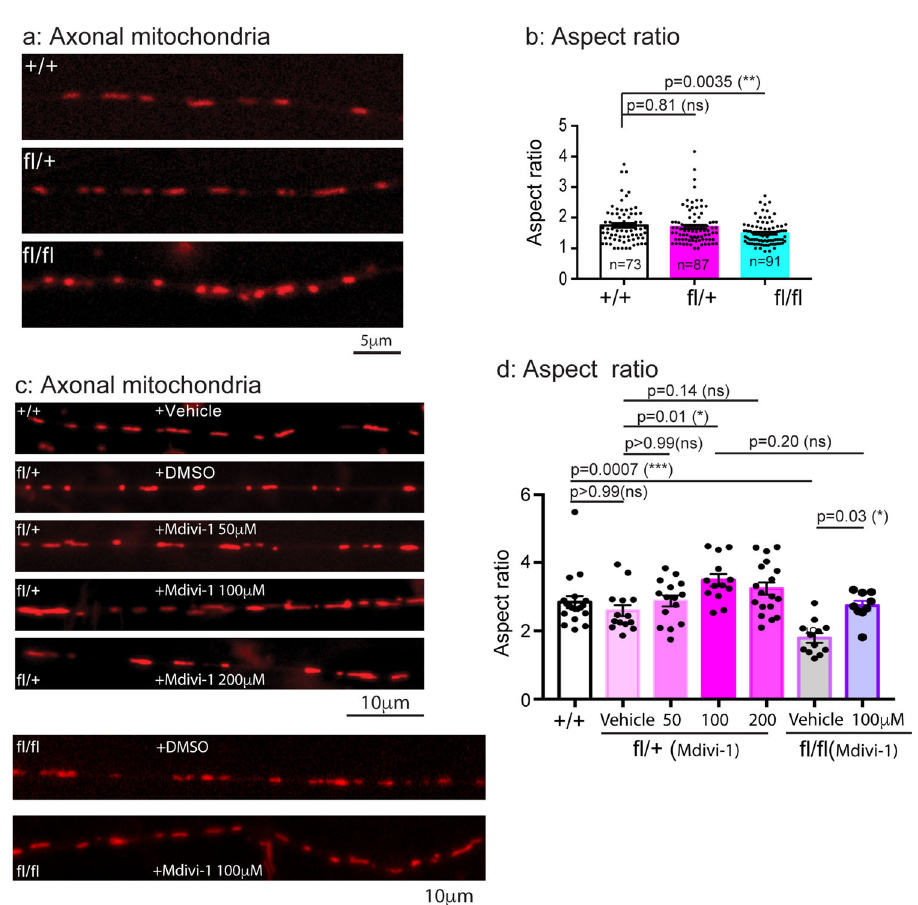
Fig. 4 Mitochondria are signi fi cantly fragmented in axons of fl / fl E18 DRG sensory neurons of the CMT2B mutant mice. E18 DRG sensory neurons from + / + , fl / + , fl / fl embryos were dissected, cultured on PLL-coated cover-glasses and maintained as described in Materials and Methods. At DIV4-7, neurons were treated with Mito Tracker and time-lapsed images were captured with live imaging microscope. a : representative images of axonal mitochondria from + / + , fl / + , fl / fl ; b : Aspect ratio for each group was measured as in Figs. 1 – 3. The numbers of mitochondria in b were analyzed are: n = 73 for + / + , n = 87 for fl / + , n = 91 for fl / fl . In c , representative images of mitochondria in axons of DRG neurons from vehicle-treated + / + , DMSO- treated fl / + or fl / + treated with 50 µ M, 100 µ M, 200 µ M Mdivi-1, fl / fl treated with DMSO or 100 µ M Mdivi-1. Quantitative measurements of aspect